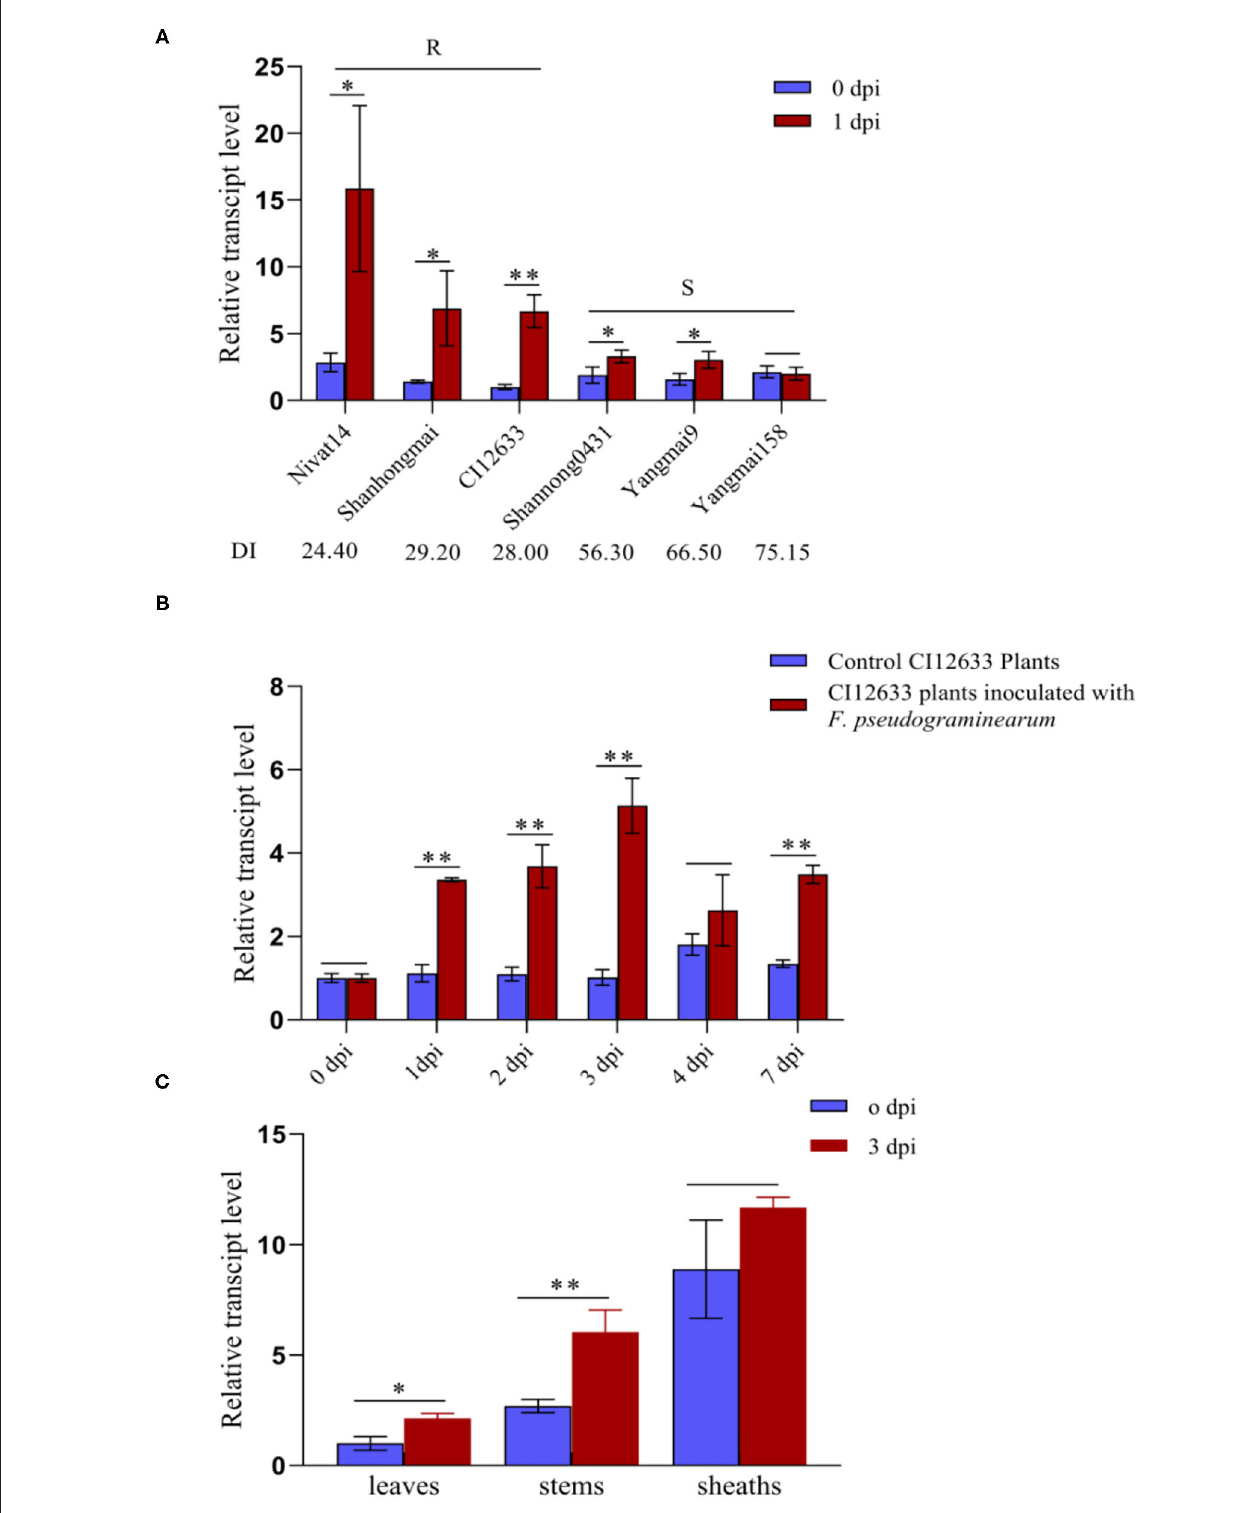
FIGURE 2 | Transcription profiles of TaWAK-6D responding to Fusarium pseudograminearum in wheat. (A) Expression patterns of TaWAK-6D in 6 wheat cultivars with different Fusarium crown rot (FCR)-resistance degrees at 0 dpi and 1 dpi with F. pseudograminearum . The expression level of TaWAK-6D in Yangmai 158 at 0 dpi was set to 1. (B) Expression patterns of TaWAK-6D in CI12633 plants with F. pseudograminearum or in control CI12633 plants at 0, 1, 2, 3, 4, and 7 dpi. TaWAK-6D transcript level with 0 dpi was set to 1. (C) Expression pattern of TaWAK-6D in leaves, stems, and sheaths of CI12633 at 0 dpi or 3 dpi with F. pseudograminearum . TaActin was used as an internal control gene ( t -test: * P < 0.05; ** P < 0.01). Bars indicate SEs of the mean.